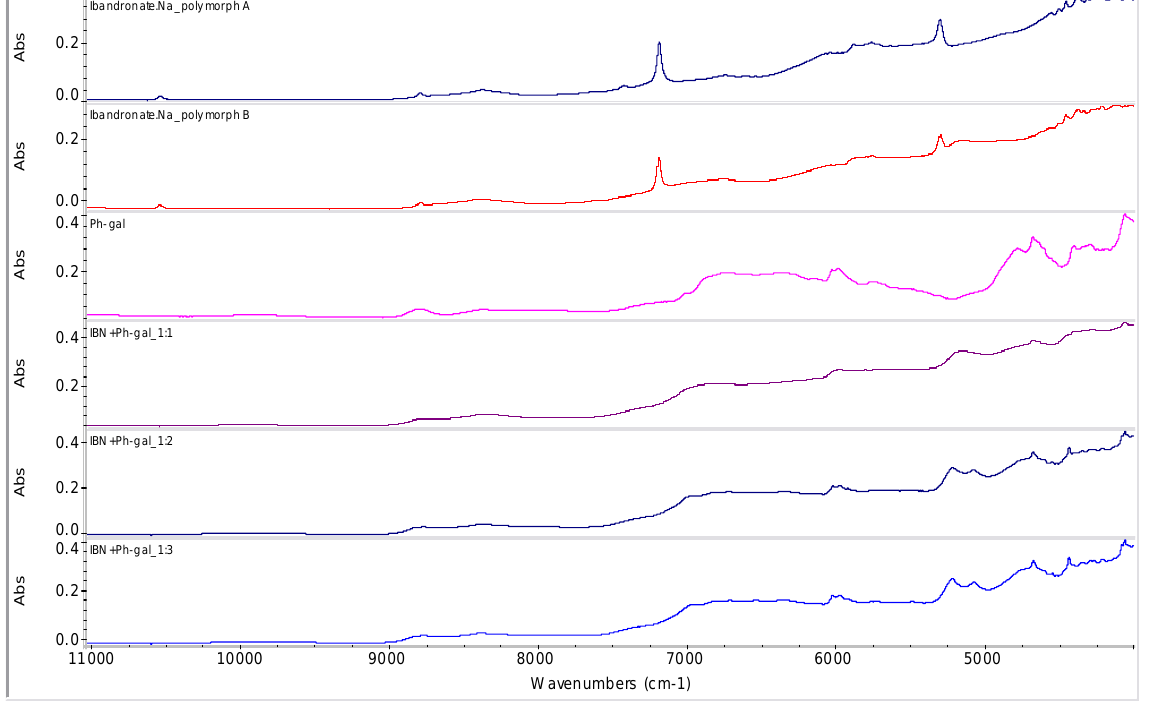
methyl- β - D -galactopyranoside: Me-gal, phenyl- β - D -galactopyranoside: Ph-gal, 2-naphthyl- β - D -